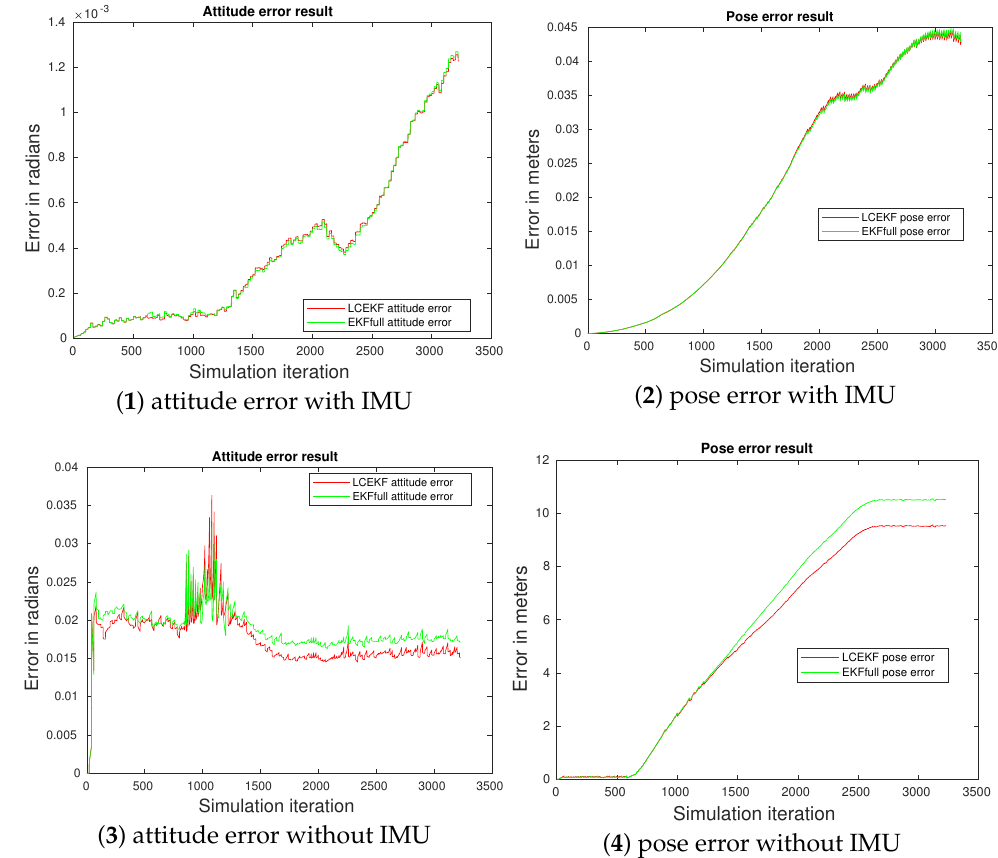
Figure 12. SLAM with constant noise (Case ii): methods’ comparison. Figures ( 1 ) and ( 2 ) represent the MSE of the pose and attitude estimation over 10 executions for the three methods while using the IMU for prediction. All the methods performed in the same way. Figures ( 3 ) and ( 4 ) represent the MSE of the pose and attitude estimation over 10 executions for the three methods while using a constant velocity model for prediction (no proprioceptive sensor). It can be seen that without the use of the IMU, both the LCEKF and EKFfull had a positioning error that increased over time (classical observed drift). Nevertheless, the LCEKF is more